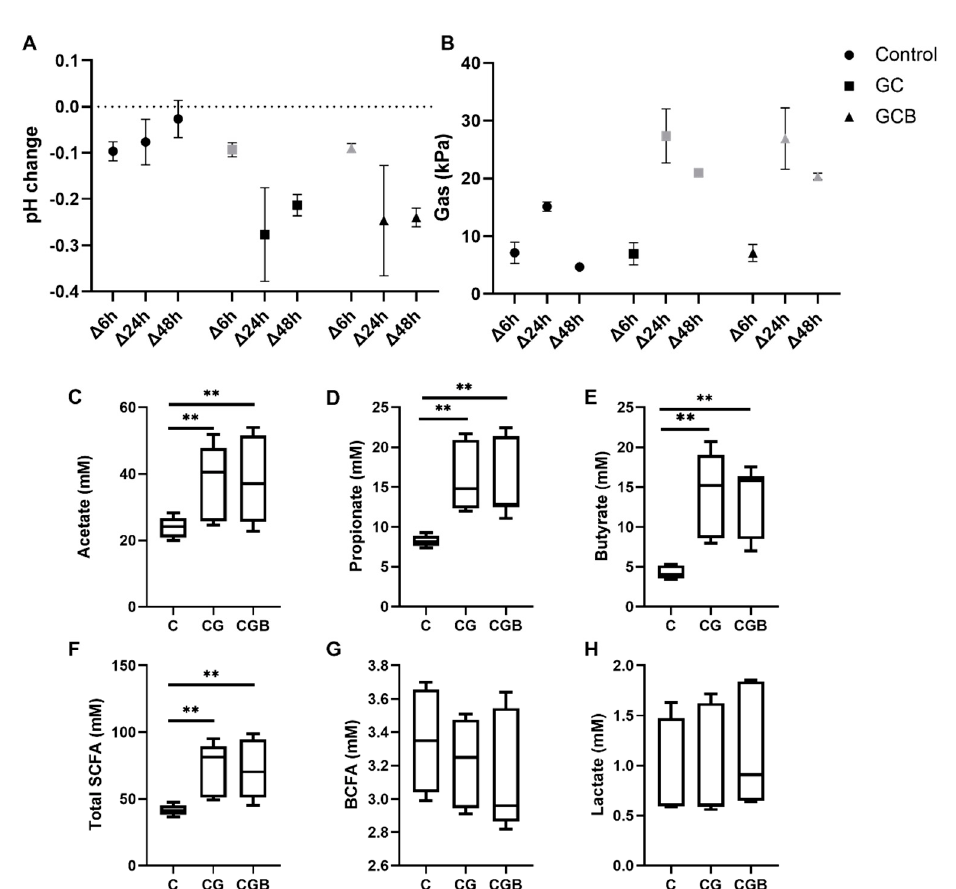
Figure 1. Effect of chitin–glucan and chitin–glucan + B. breve on markers of gut microbial metabolism. ( A ) Gas and ( B ) pH change at different time intervals; ( C – E ) represent box plots of acetate, propionate, butyrate, total SCFA, BCFA ( ∆ 48 h), and lactate ( ∆ 6 h) change for different treatments. ( A , B ) graphs represent mean ± SEM, n = three donors. Box plots represent data from n = three donors with the line at the mean. Statistically significant differences ( p < 0.05) between treatments and controls are marked with grey symbols in ( A , B ) and with asterisks (** p < 0.01) in ( C – H ).